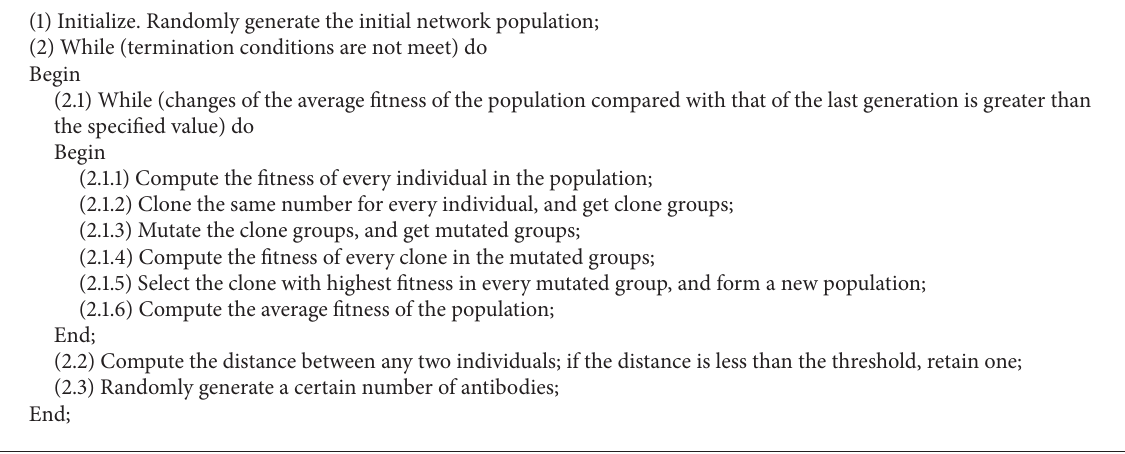
Algorithm 1: The description of